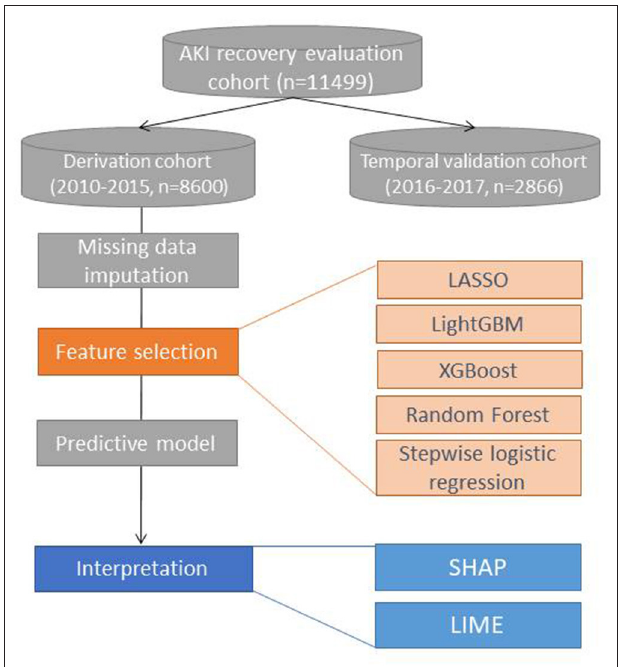
FIGURE 1 | Study analysis flow. LR, logistic regression; LASSO, least absolute shrinkage and selection operator; XGBoost, eXtreme Gradient Boosting; LightGBM, Light Gradient Boosting